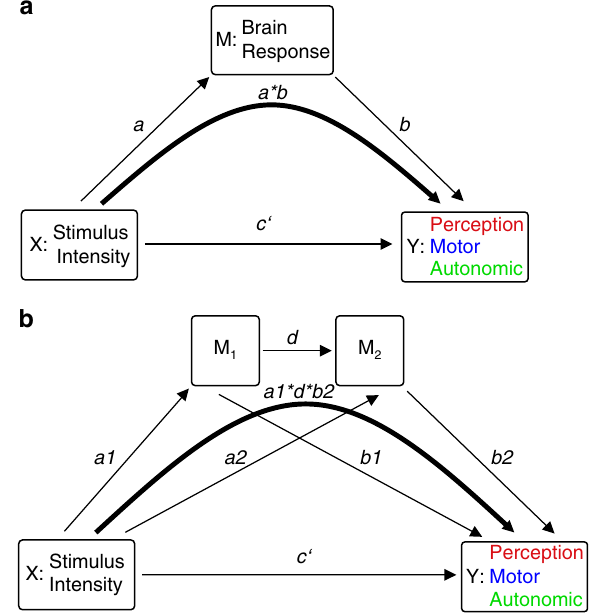
Fig. 4 Mediation analysis. a Two-path mediation model with a representing the relation of X to M , b the relation of M to Y controlled for X , and c ′ the relation of X to Y controlled for M . Mediation effects are calculated by multiplying coef fi cients of path a and path b and tested for signi fi cance using a bootstrap approach. b Three-path mediation model linking stimulus intensity ( X ) and the perceptual, motor, or autonomic dimension of pain ( Y ) via two sequential mediators ( M 1 and M 2)